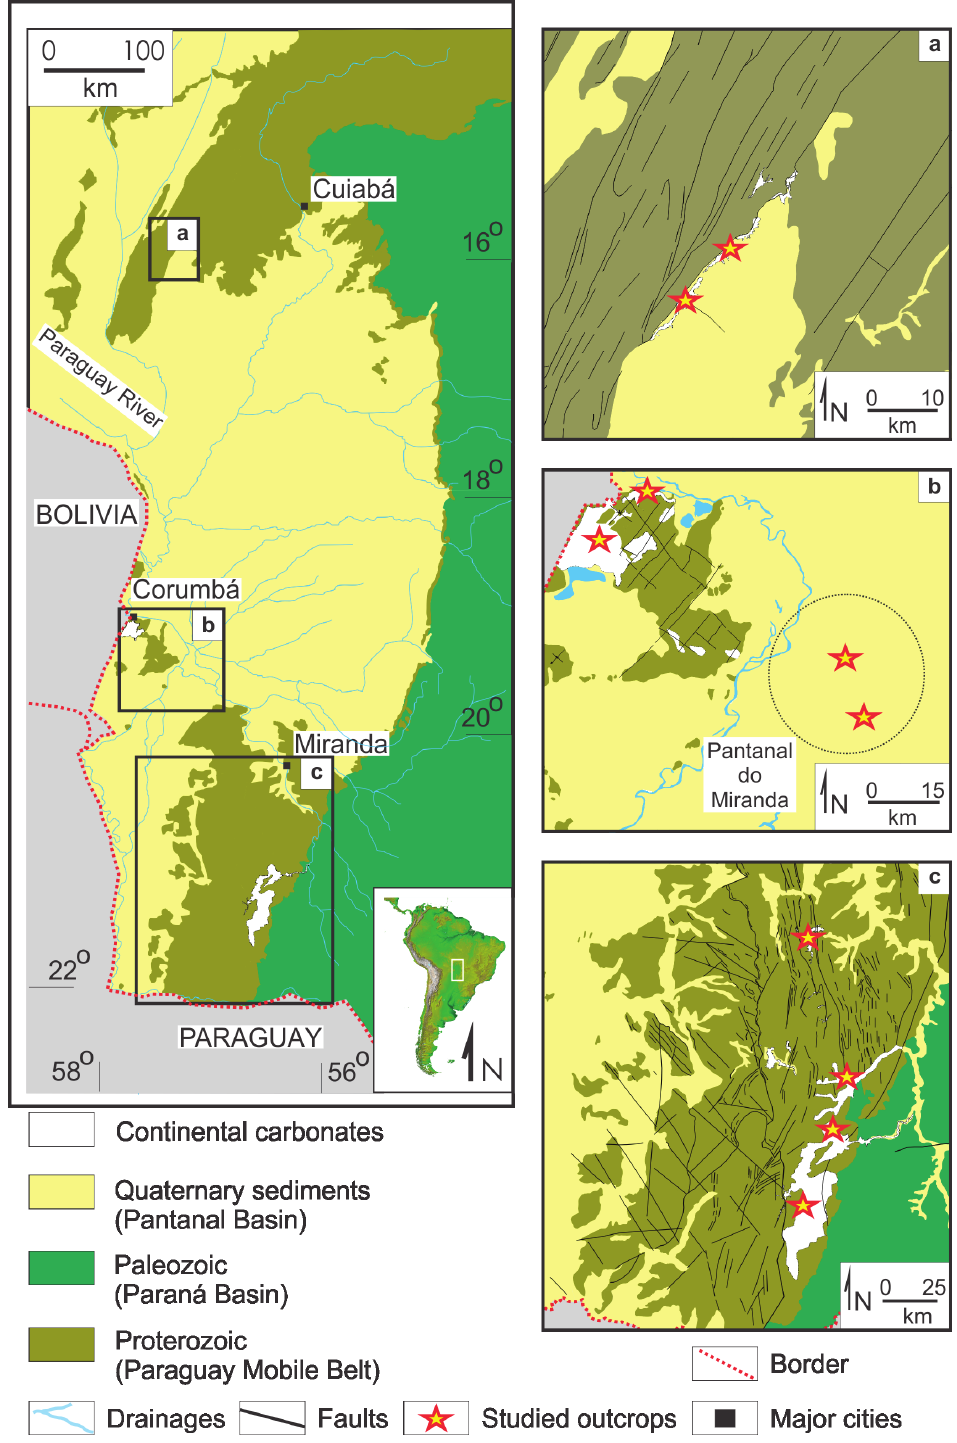
Figure 1 - Simplified geological map of Paraguay’s Mobile Belt indicating location of studied areas: a : Serra das Araras; b : Corumbá/Ladário plateau and Pantanal do Miranda; c : Serra da Bodoquena (modified from Lacerda Filho et al. 2004a, b, Valente et al.